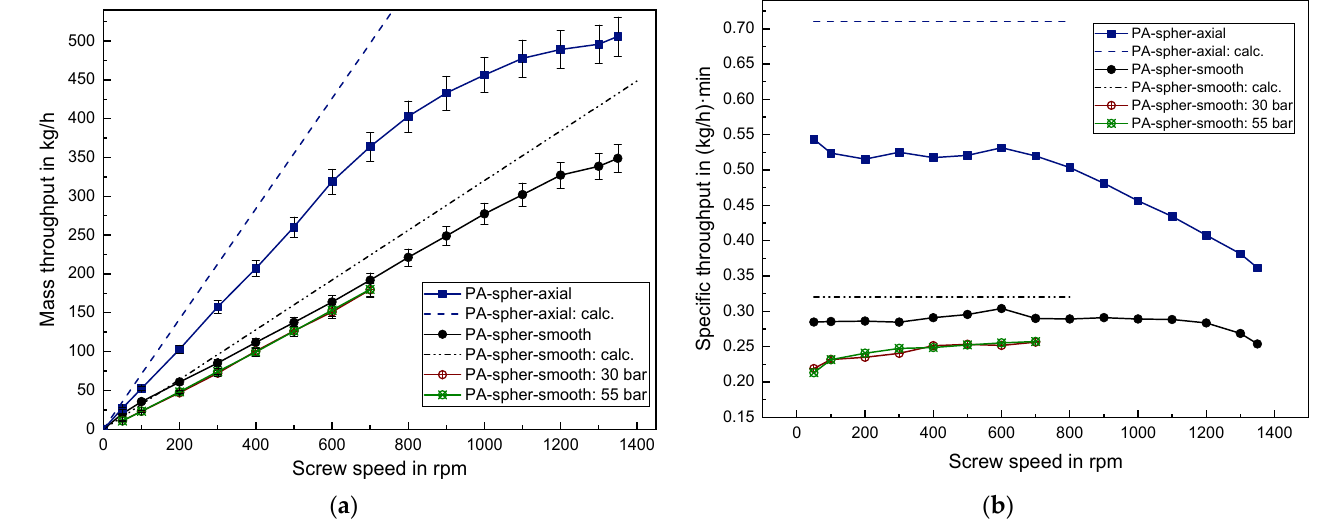
Figure 10. ( a ) Absolute mass throughput and ( b ) specific mass throughput for spherical